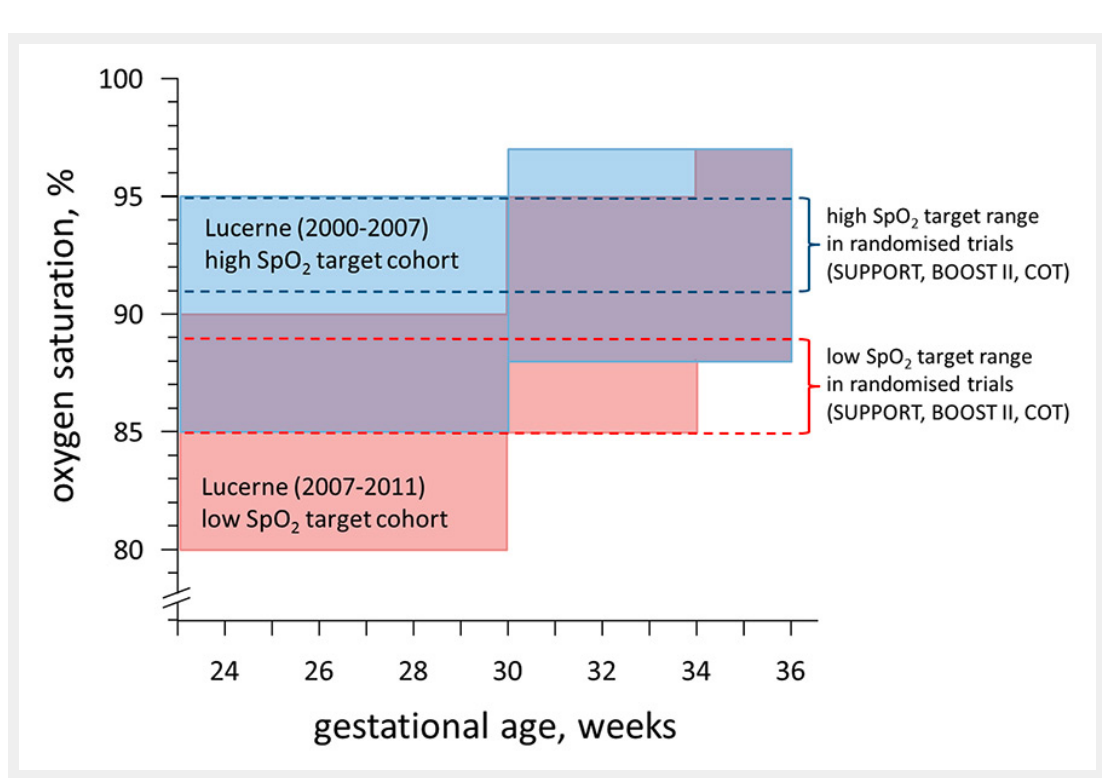
Figure 1 Oxygen saturation (SpO 2 ) target policies at the Children’s Hospital of Lucerne: (A) between 1 January 2000 and 30 June 2007, SpO 2 targets were 85 to 95% at <30 weeks and 88 to 97% at ≥30 weeks (high SpO 2 target cohort); (B) between 1 July 2007 and 31 December 2011, SpO 2 targets were lowered to 80 to 90% at <30 weeks, 85 to 95% between 30 and 34 weeks and finally 88 to 97% at ≥34 weeks (low SpO 2 target